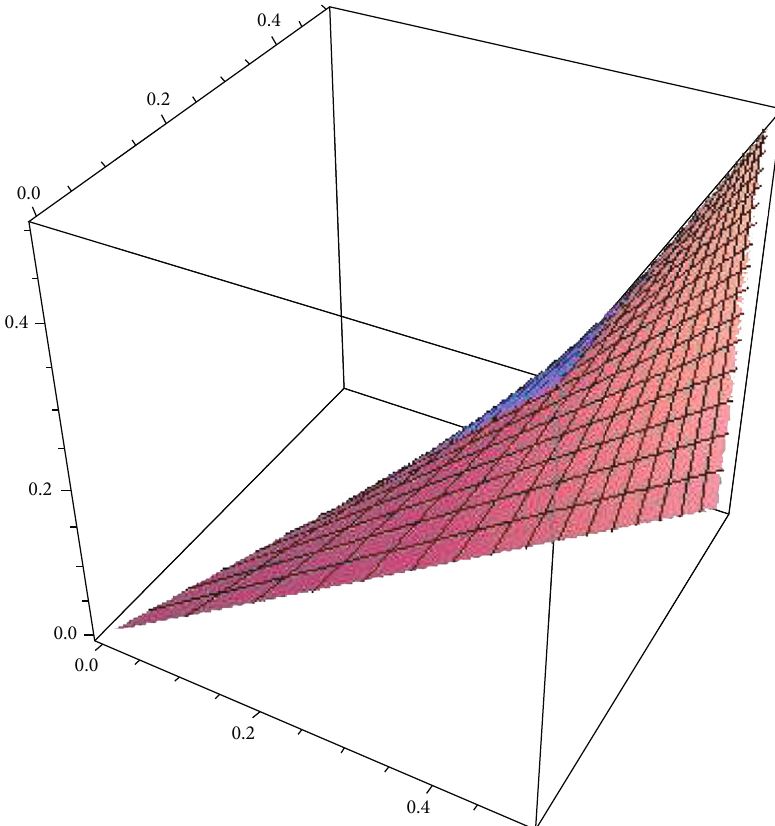
Figure 8: Bilinearly blended Coons patch by using rational blending